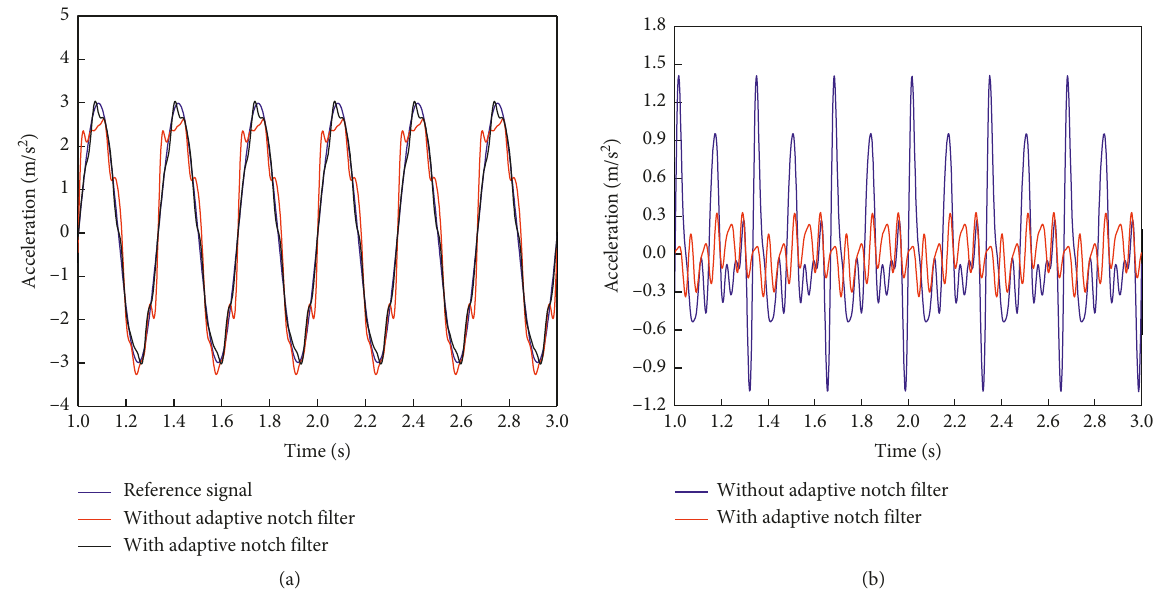
Figure 14: Sine acceleration response. (a) Tracking performance. (b) Tracking